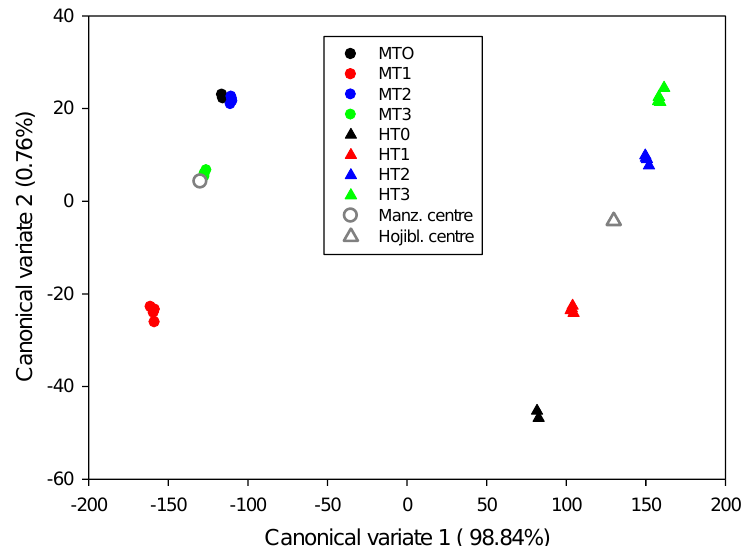
Figure 5. Segregation of processing phases by canonical variate plot of ilr coordinates , according to cultivars. The coordinates were obtained following Ward’s clustering structure. The overall centres for Manzanilla and Hojiblanca are also plotted. M, Manzanilla; H, Hojiblanca; T0, fresh olives; T1, lye-treated olives; T2, fermented olives; T3, packaged olives.